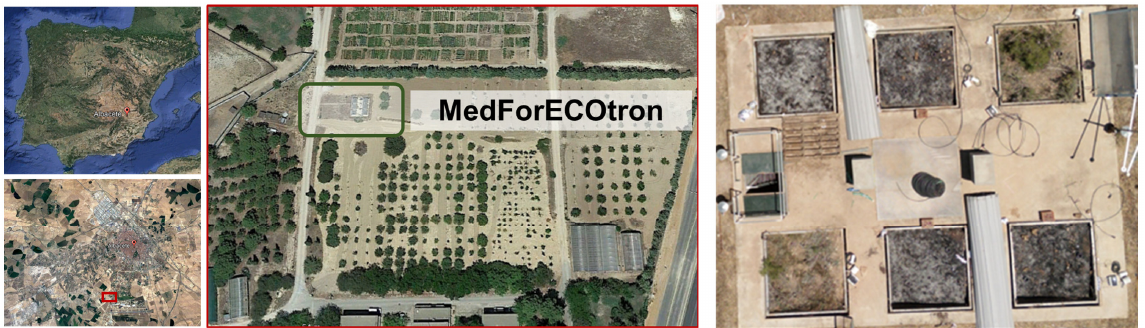
Figure 1. Location of the study area in the Iberian Peninsula (red dot in the top left image) and location in Albacete (red rectangle in the bottom left image). The pilot plant facility was installed at the Higher Technical School of Agricultural and Forestry Engineers in Albacete (green rectangle in the right-hand image). Zenital perspective (bird’s eye view) of the burned monoliths at MedForECOtron (right image): two unburned plots (green vegetation), two plots simulating low burn severity (dark black-grayish ash cover), and two simulating high burn severity (light gray-whitish ash cover).